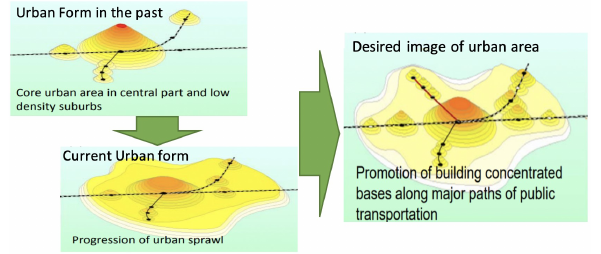
Figure 2. Formulating an urban plan for compact cities